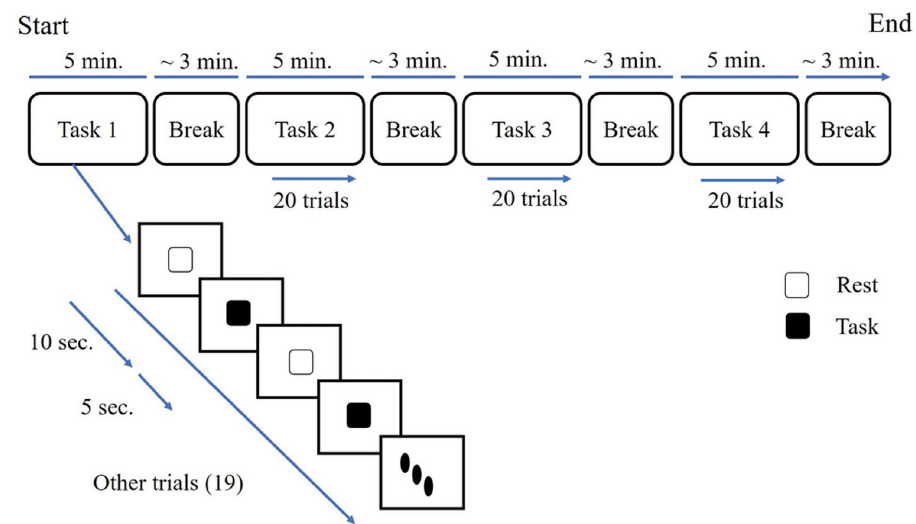
Fig 1. Schematic illustration of the timeline for a complete session is sketched. For instance, in this figure, we have shown a session with the task order of 1-2-3-4. Each session included 4 tasks (2 dynamic and 2 static tasks). In each task, subjects completed 20 trials. The tasks were randomly presented (Note: Here we only showed the 1-2-3-4 order. Other random sequences are presented in Table 1 which shows the specific order for each subject)). Between switching to the next task, subjects had a break time of about 3 minutes. In each trial, the contraction time was 5 seconds and the rest time was 10 seconds. Each task took about 5 minutes. Total time of complete session without considering the preparation time was about 32–35 minutes.